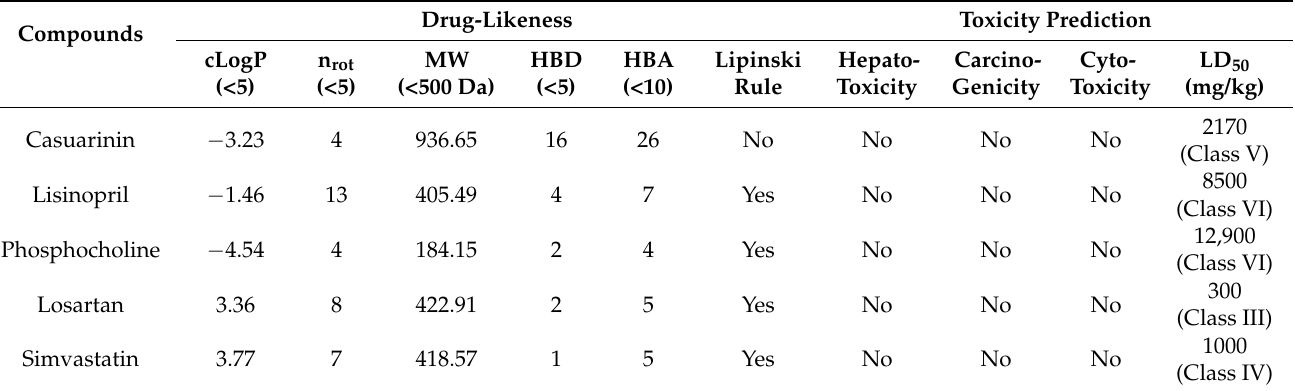
Table 3. Drug-likeness and toxicity prediction of top-ranked phytocompound from T. arjuna and standard